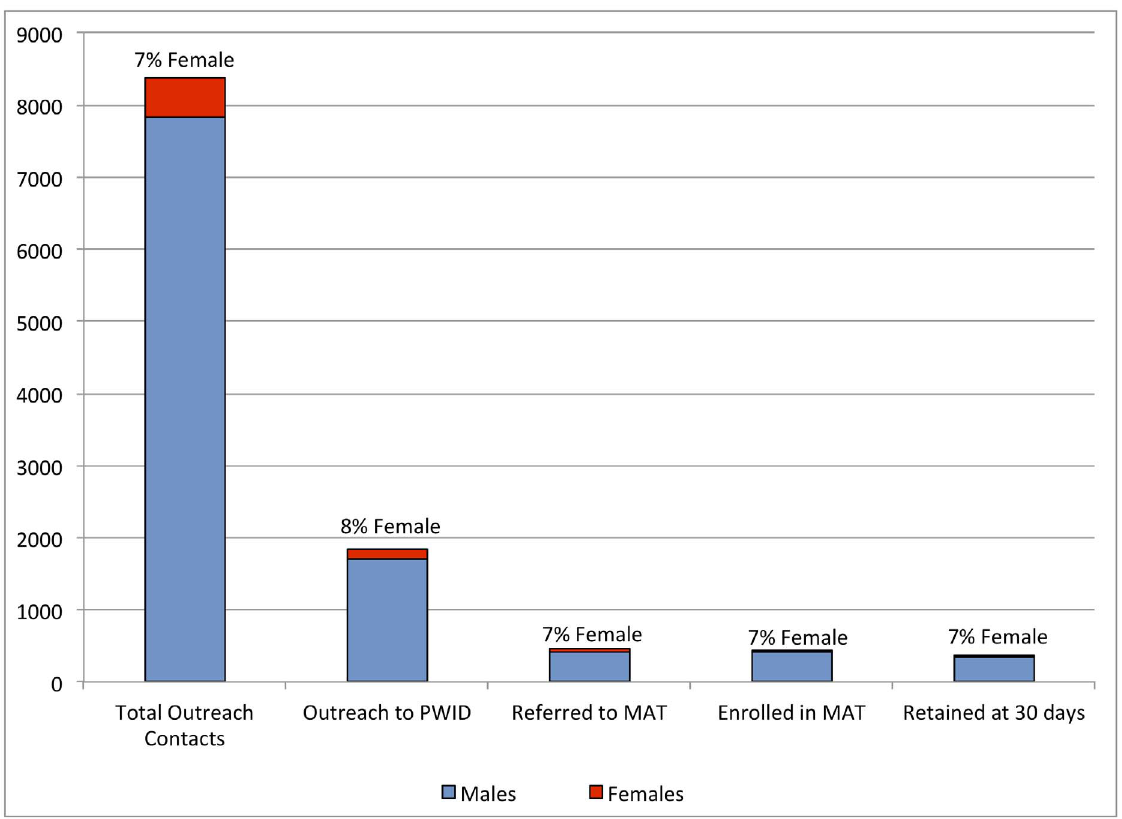
Figure 1. Client Flow from Outreach to Enrollment into Medication Assisted Treatment (MAT). doi:10.1371/journal.pone.0067062.g001 PLOS ONE |